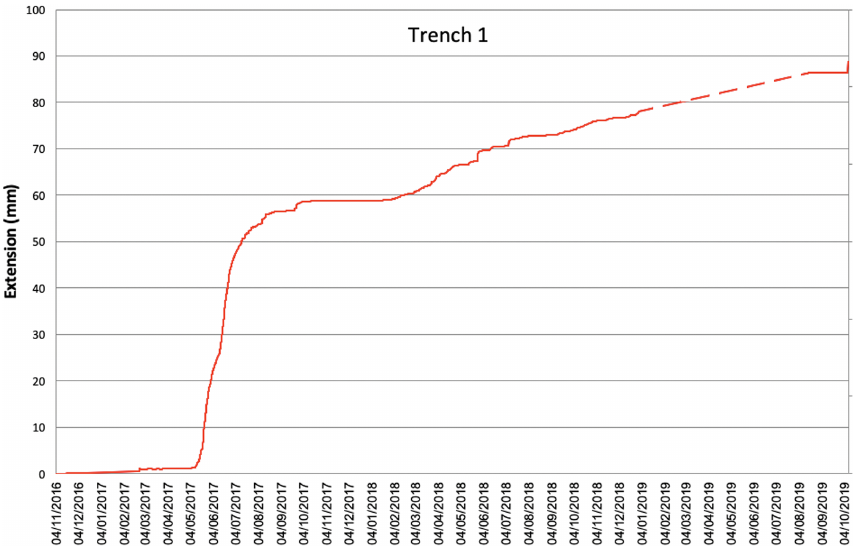
Figure 6. Graph showing the readings of the incremental extension (in mm), associated with landslide surface displacement, recorded by station no.1 from November 2016 to October 2019.